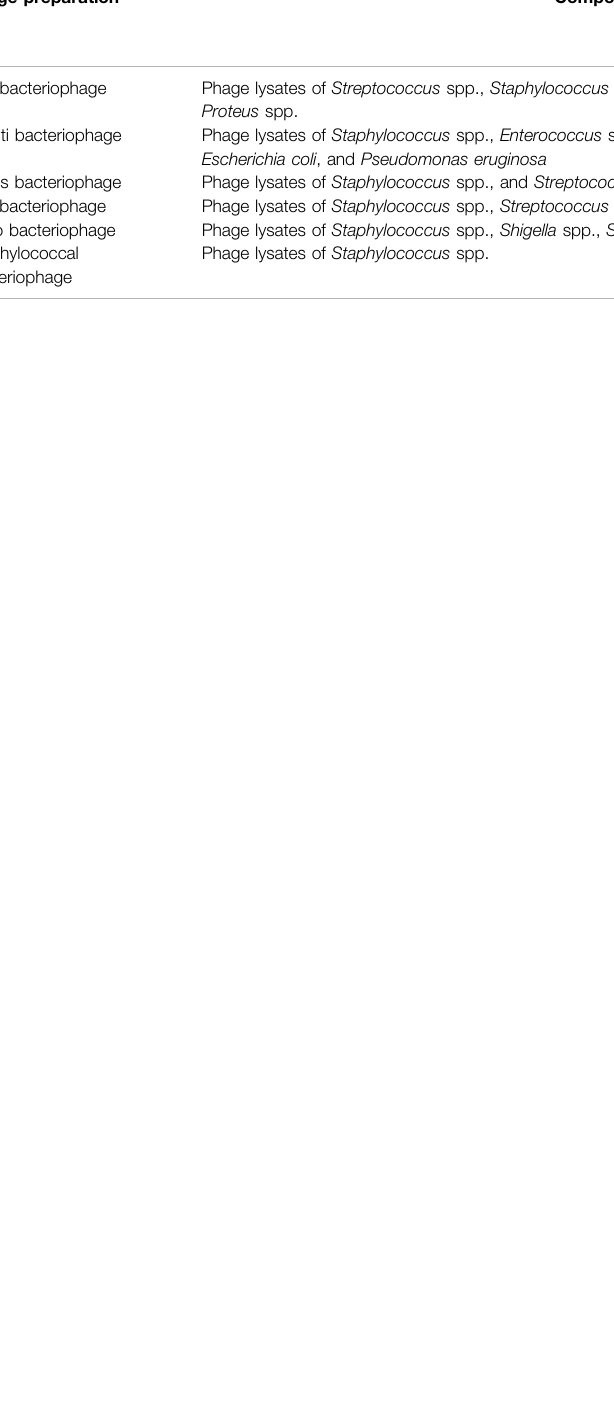
TABLE A1 | Standard Phage Preparations made by the Eliava Institute of Bacteriophages, Microbiology and Virology. Phage preparation Composition Titer: PFU